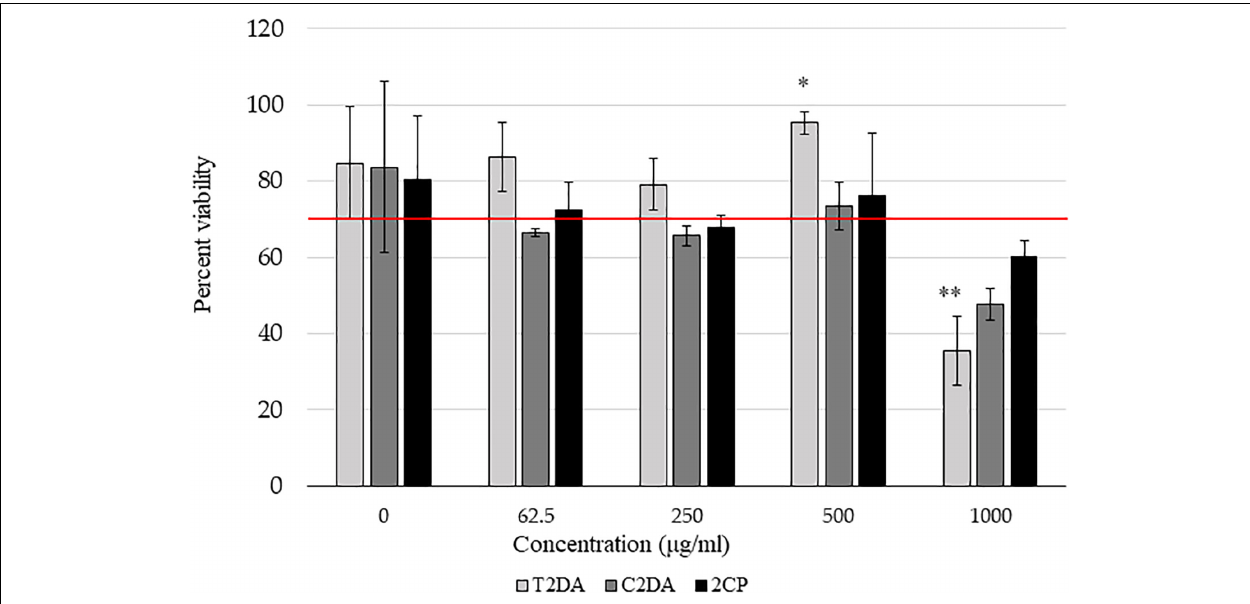
FIGURE 2 | NIH-3T3 cytocompatibility assay results showing the percentage of viable cells compared to non-ethanol controls 24 h after addition of fatty acids. Asterisks represent significant differences between the other groups ( ∗ p < 0.05, ∗∗ p < 0.01), detected by one-way ANOVA with the Holm–Sidak post-hoc tests. Data represent mean ± standard